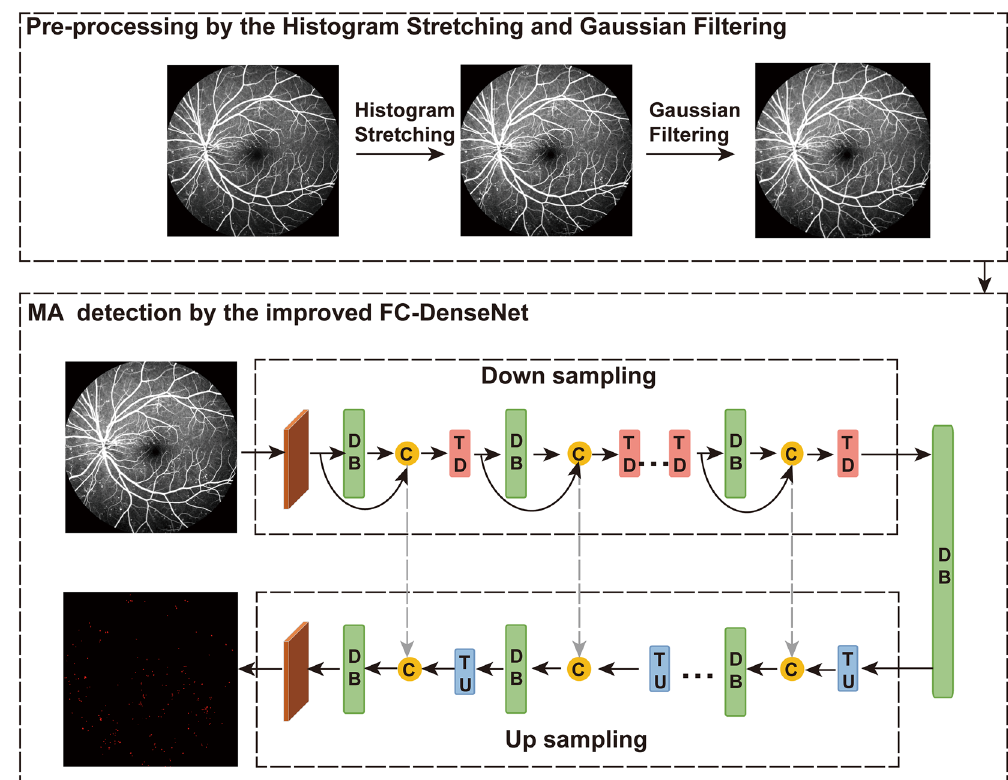
Figure 2. Flowchart of